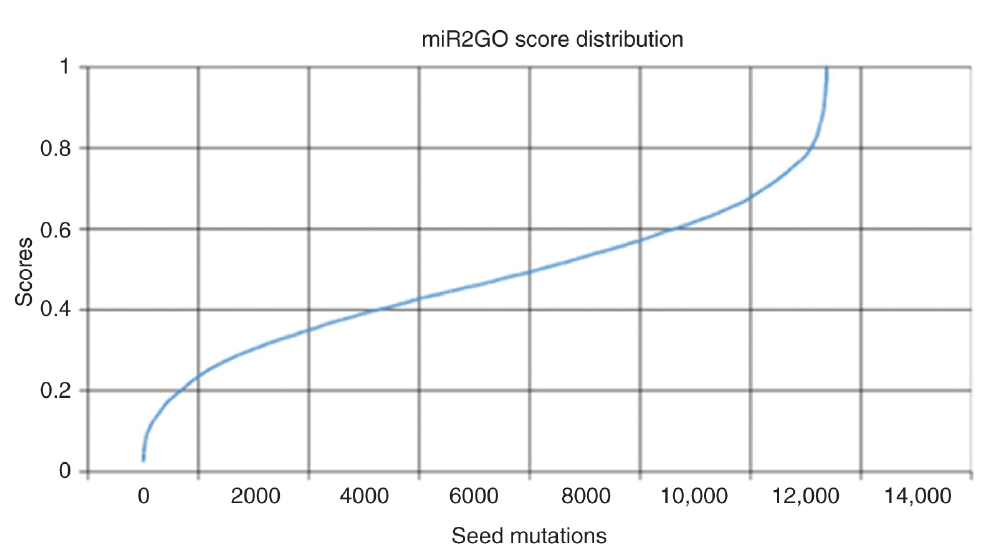
Figure 2: Distribution of miR2GO scores for all possible seed